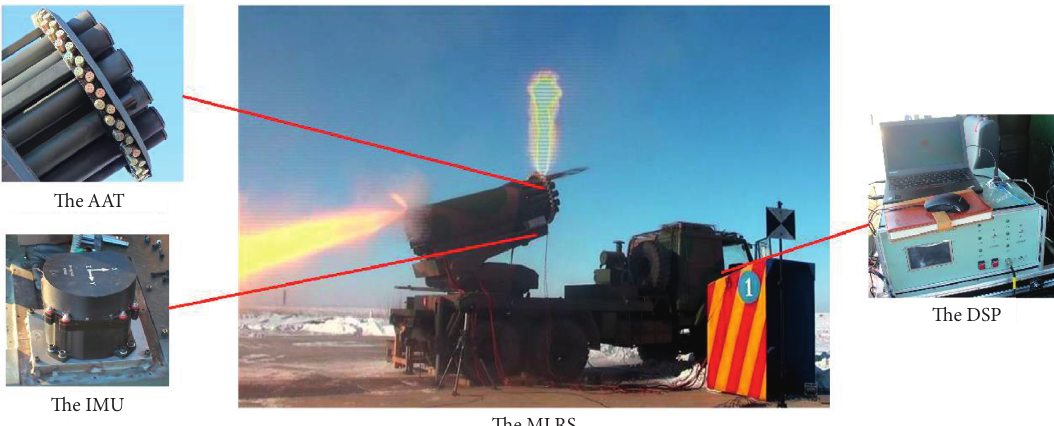
Figure 11: The prototype of the proposed control